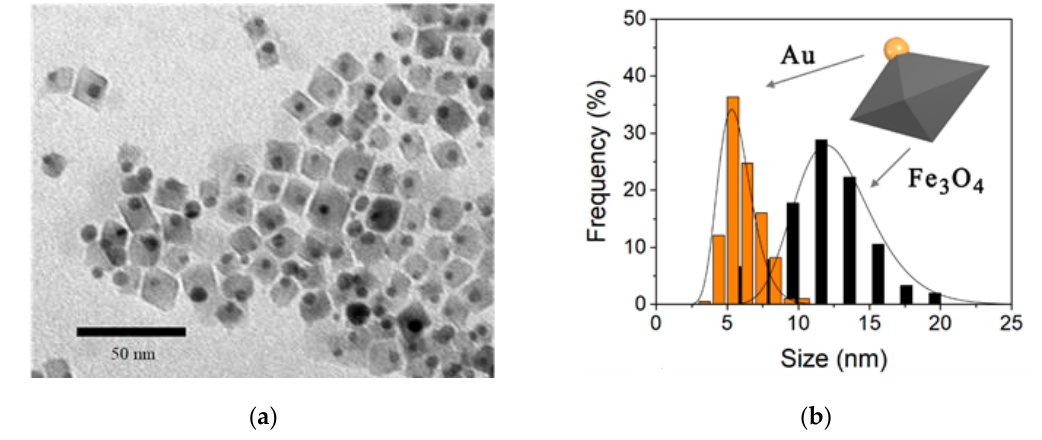
Figure 1. ( a ) Transmission electron microscopy (TEM) image of Fe 3 O 4 -Au and ( b ) size distribution of the gold (red bars, sphere diameter) and magnetite (blue bars, octahedra diagonal) components.